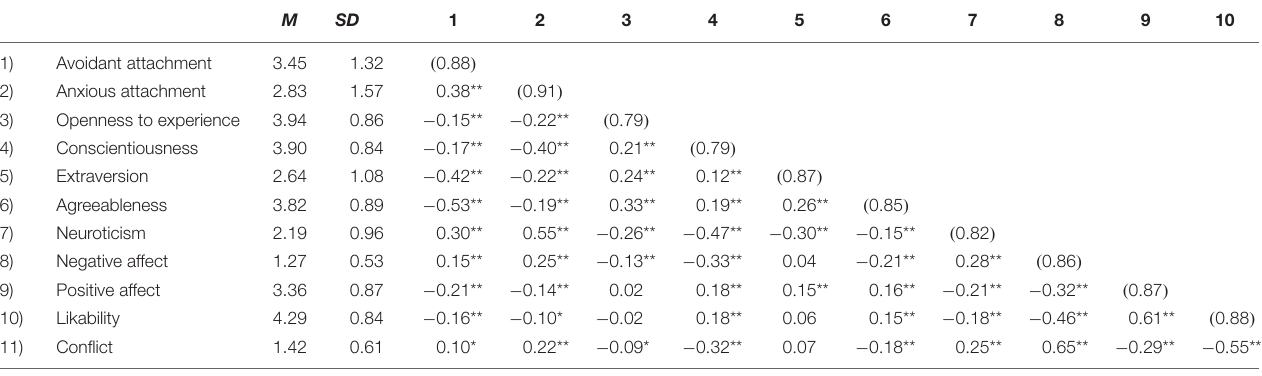
TABLE 2 | Simple correlations between main variables (Study 1).